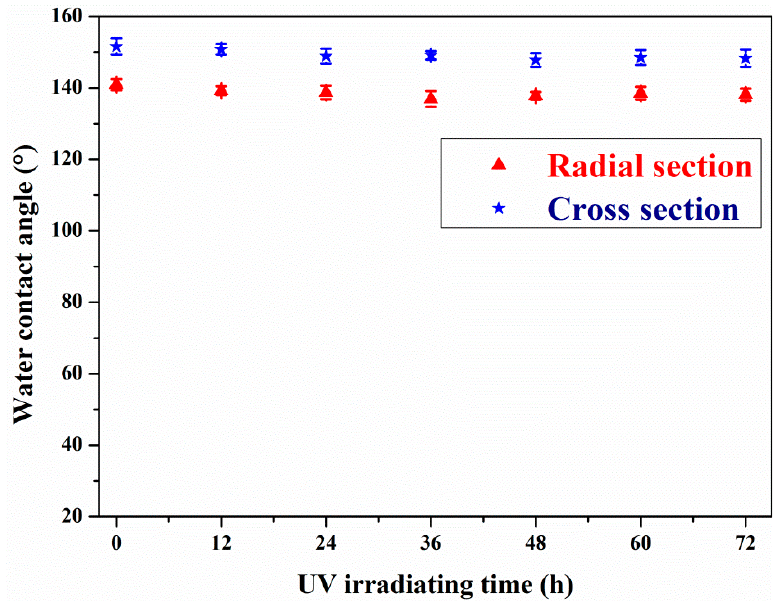
Figure 7. UV radiation resistance test of D4H modified wood.